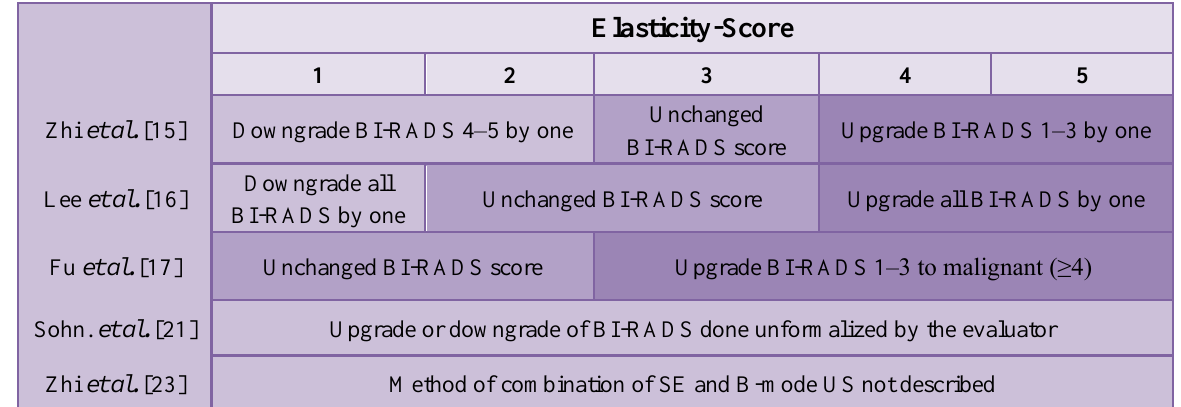
Table 2. Alteration of Breast Imaging Reporting and Data System (BI-RADS) score by the elasticity-score in the five studies, which reported diagnostic values for the combination of B-mode and SE-US. BI-RADS scores 1–3 usually designate a benign tumor, while BI-RADS 4–5 designate